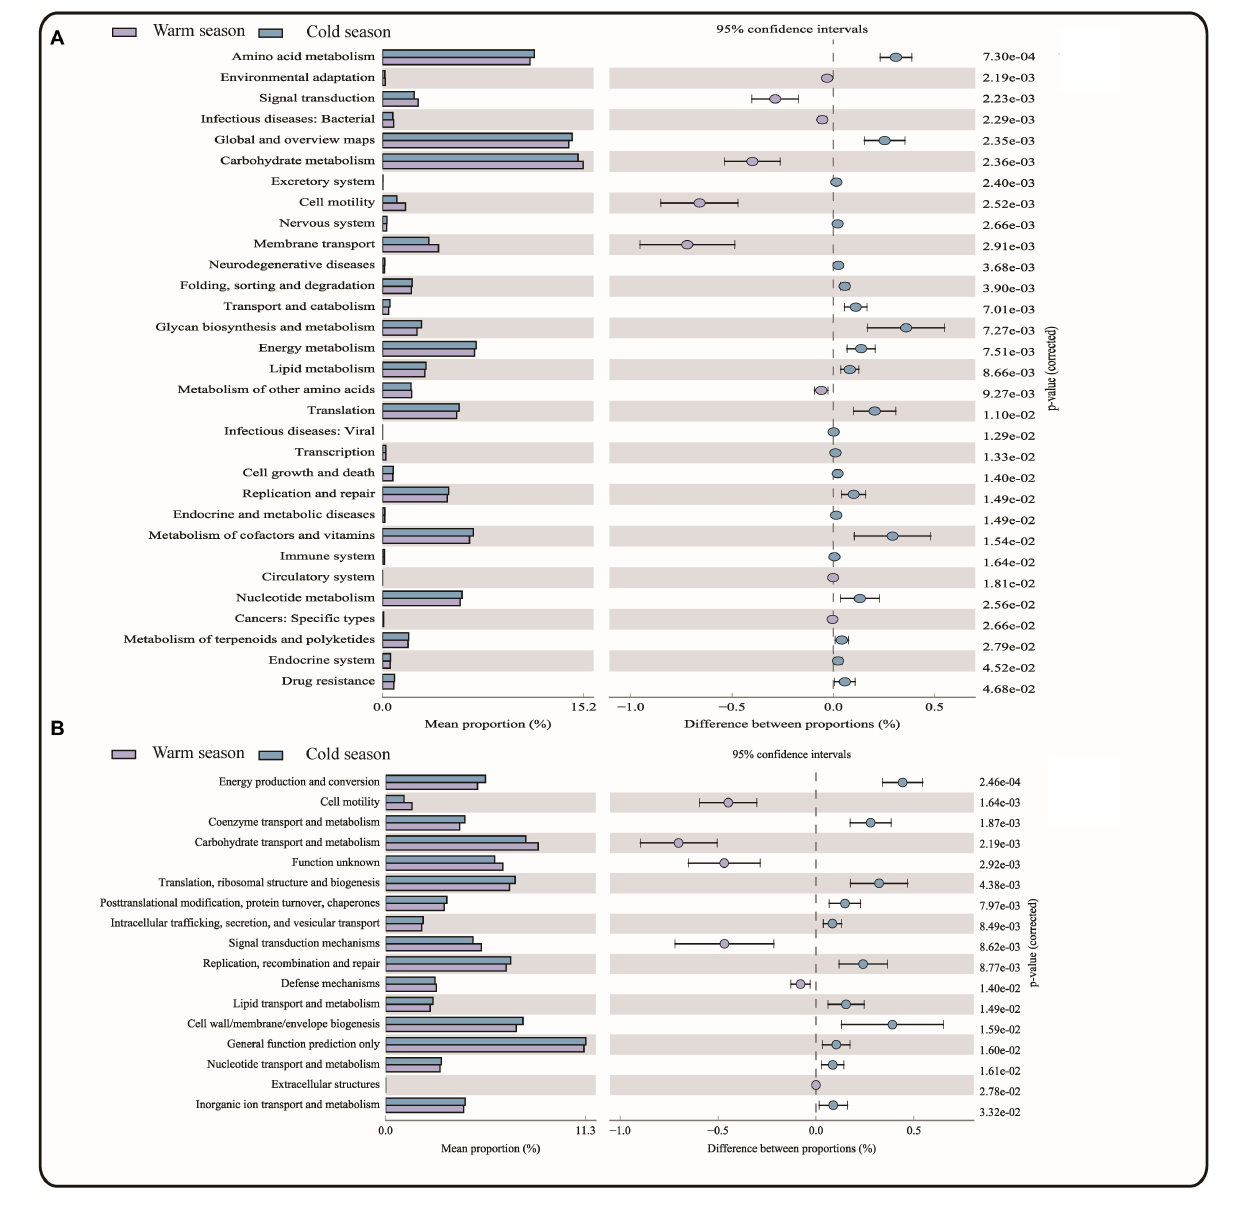
FIGURE 4 | (A) KEGG functional pathway; (B) COG functional